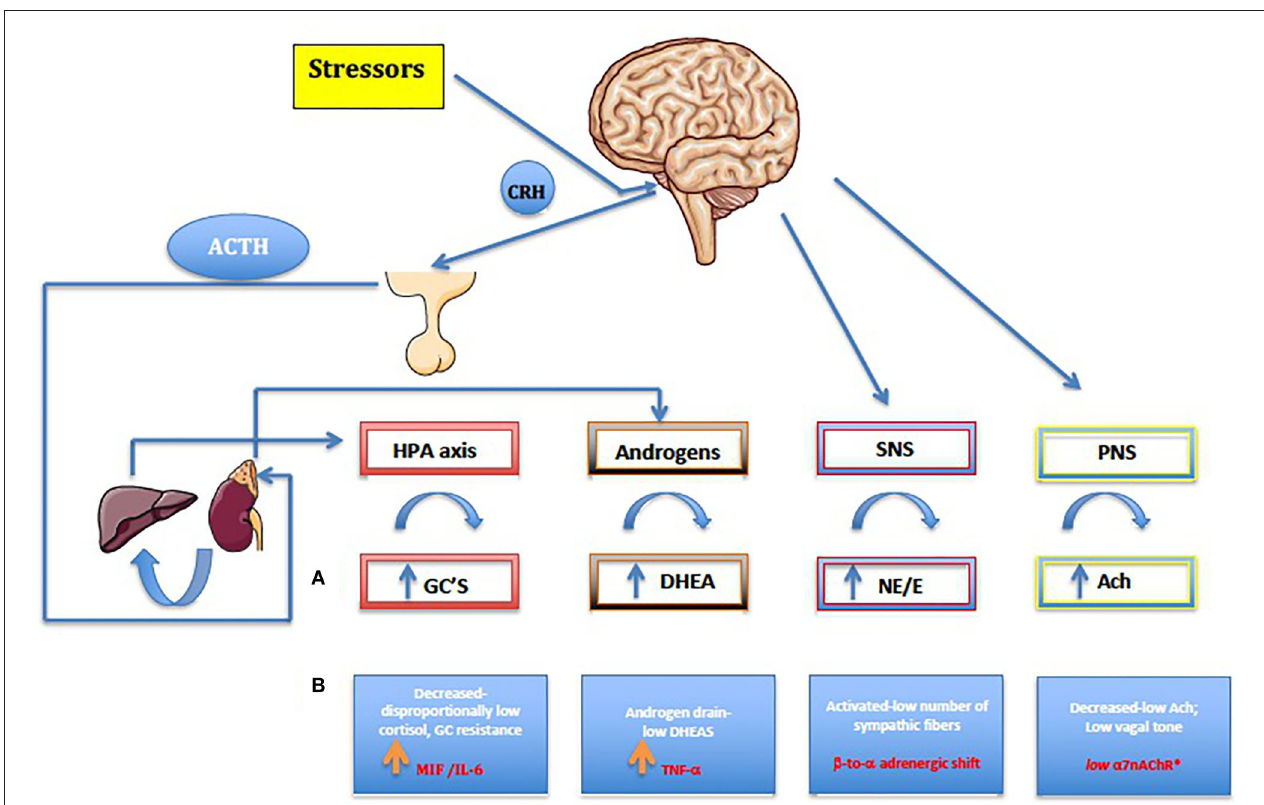
FIGURE 1 | (A) Normal, healthy neuroendocrine pathways seen also in reactive and early undifferentiated arthritis. (B) Chronic arthritis including jSpA. Along with the autonomic nervous system (SNS and PNS), the HPA axis is the main stress response mechanism, forming a carefully regulated signaling network. HPA axis dysregulation results in various downstream physiological consequences, like increasing risk for immune-mediated disease, mood disorders, metabolic disease, and cardiovascular disease. On the other hand, gonadal hormones play a master role in the formation, activation, and regulation of HPA axis. By affecting the response and sensitivity to cytokines, neurotransmitters, and hormones, gonadal steroids help to HPA axis to fine-tune the levels of stress hormones in the circulation. Furthermore, the behavioral responses to stress and obvious sex differences are particularly important considering their role in maintaining homeostasis. Pro-inflammatory cytokines namely MIF, TNF- α and IL-6 have a major role in shaping up final anti-stressor response during the chronic inflammation. Furthermore, centrally produced MIF by pituitary gland, was the first cytokine that can counter-regulate the inhibitory effects of glucocorticoids and, as a result, plays a critical role in the host control of inflammation and immunity in general. Imbalance in the autonomic nervous system (ANS) or dysautonomia has been detected in many established chronic autoimmune diseases, and in general, patients with chronic synovitis have increased activation of sympathetic fibers (ß to α adrenergic shift) and reduced PNS activity ( low a7nAChR ). For the details see text (32–65). HPA, hypothalamic-pituitary-adrenal axis; CRH, corticotropin-releasing hormone; ACTH, adrenocorticotropic hormone; GC, Glucocorticoids; ACh, acetylcholine; NE, norepinephrine; E, epinephrine; DHEA,